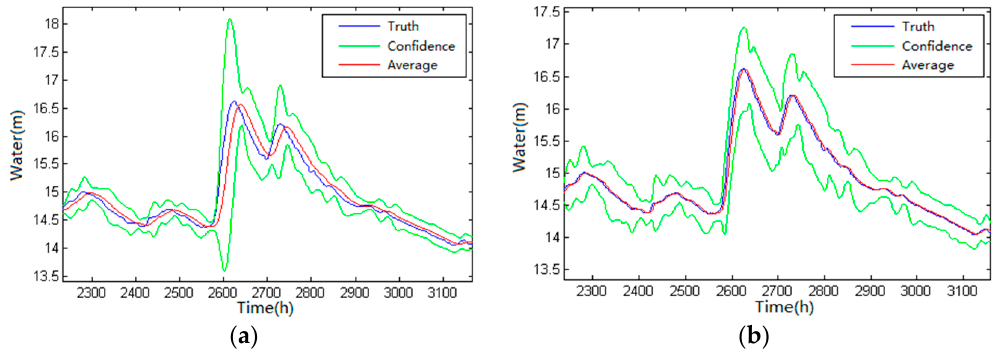
Figure 14. ( a ) The flood season of the Guxiandu station under a basic statistical control method. ( b ) The flood season of the Guxiandu station under the statistical control method in this paper.